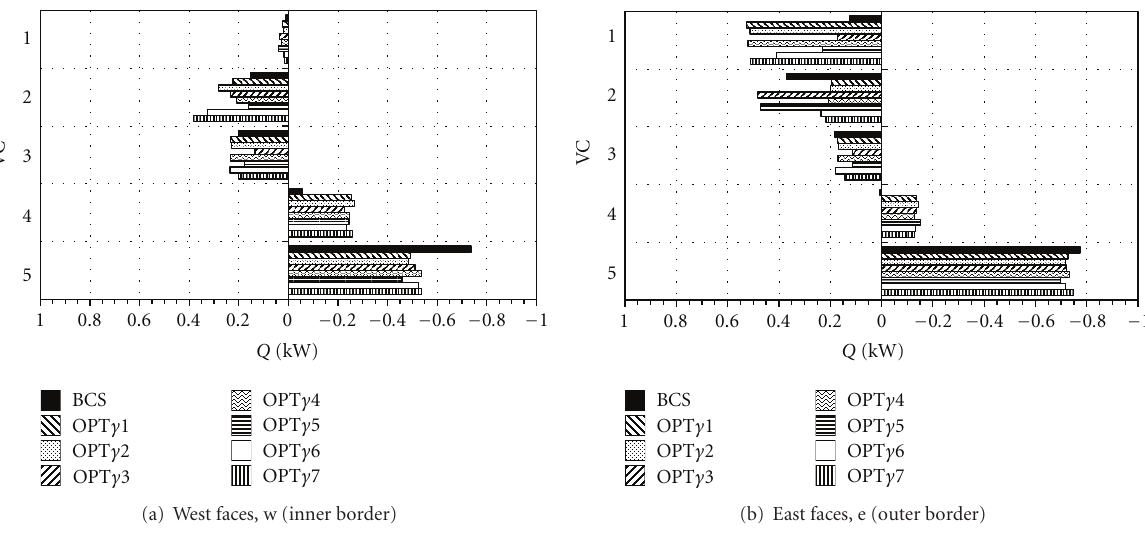
Figure 7: Enthalpic flow rate predictions across West (inner border) and East (outer border) of the air curtain control volumes, per unit length—OPT γ cases